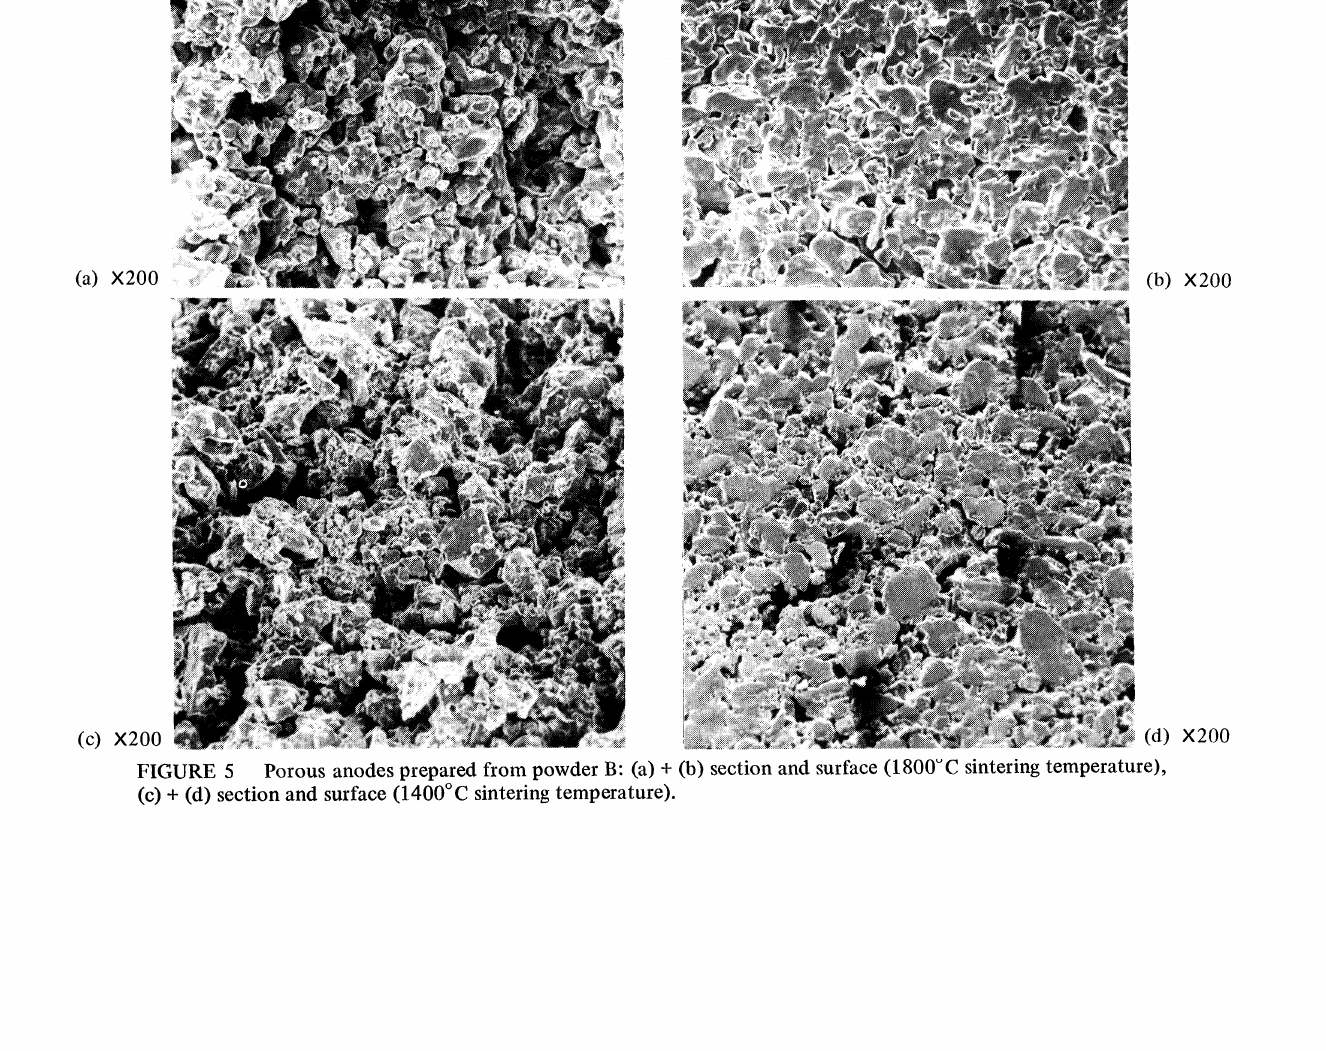
Porous anodes prepared from powder B: O) + (b) section and surface (1800C sintering temperature), (c) + (d) section and surface (1400C sintering